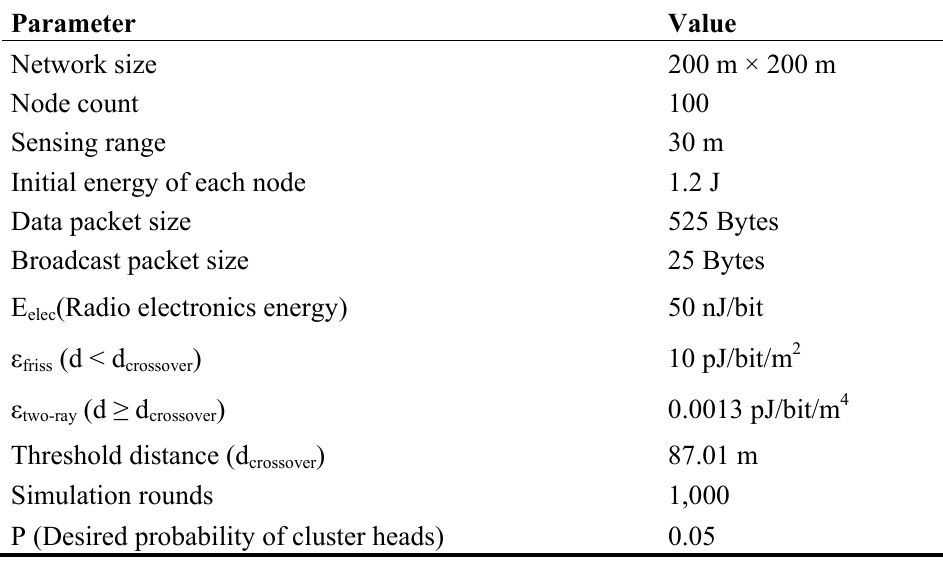
Table 2. Simulation